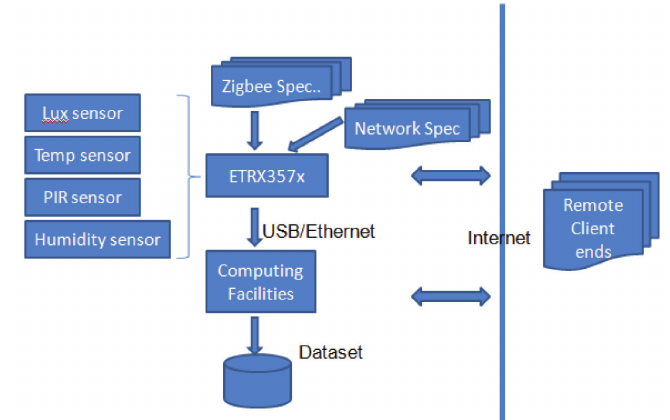
Fig. 4. An example of a wireless sensor network deployment